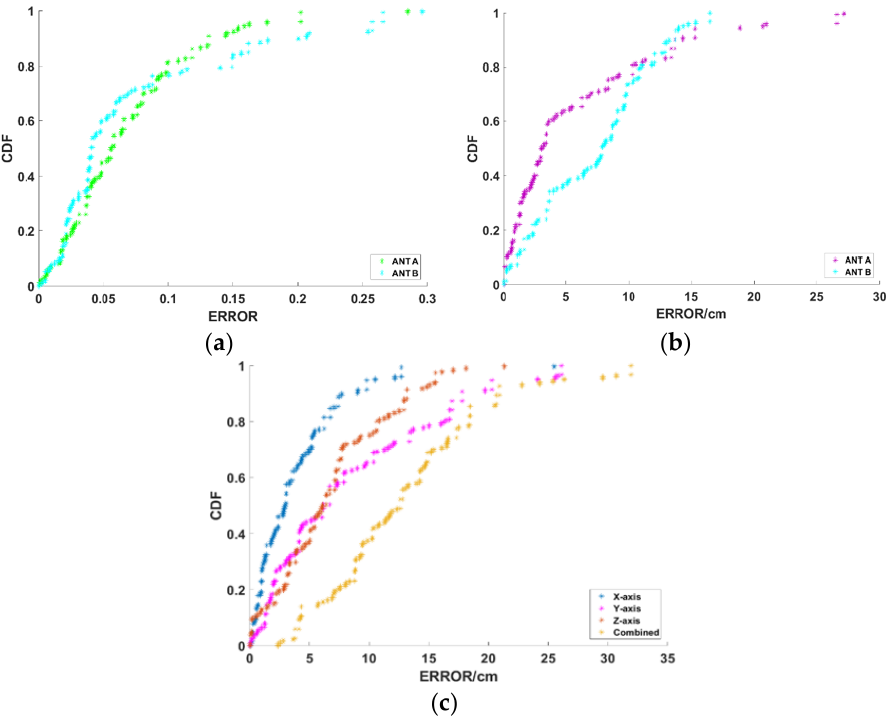
Figure 17. Localization error in 3D. ( a ) Relative incident angle error in 3D; ( b ) Distance calculation error in 3D; and, ( c ) Localization error in 3D.